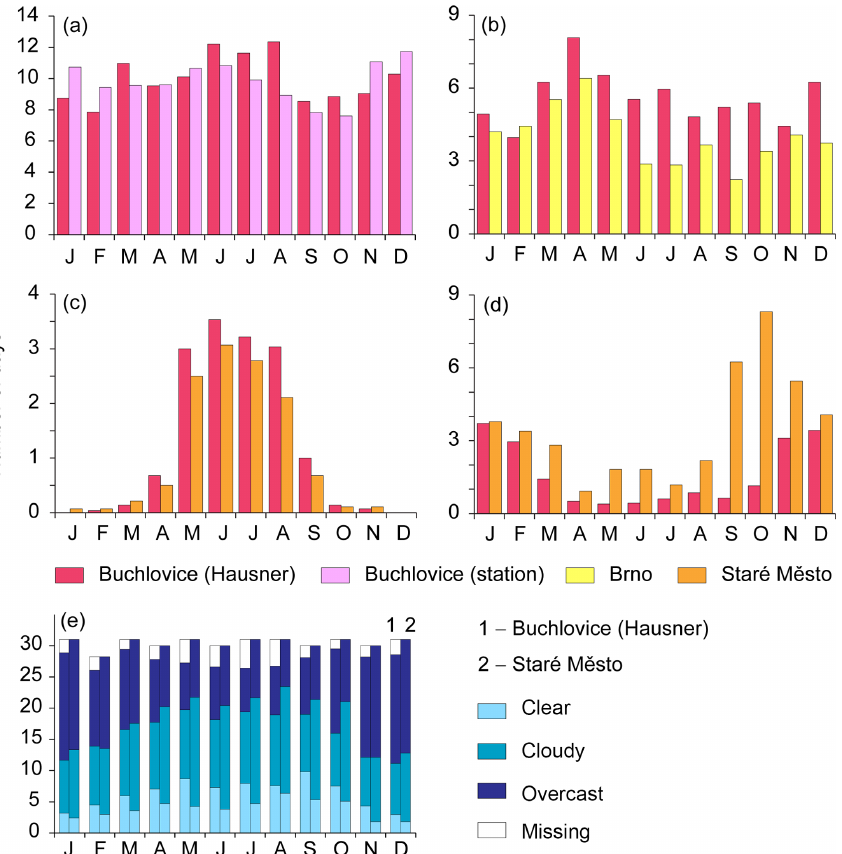
Figure 13. Comparison of annual variation in selected climatological characteristics at Buchlovice interpreted from Hausner’s records for 1803–1830 and at three selected meteorological stations in 1961–1990: (a) number of precipitation days (with totals ≥ 0 . 1mm for the Buchlovice rain-gauge station); (b) number of days with strong winds (with wind force ≥ 7 ◦ B, i.e. wind speed ≥ 10 . 8ms − 1 for Brno); (c) number of days with thunderstorm; (d) number of days with fog; (e) number of days with various degrees of cloudiness: clear days (0–2/10 of cloud cover at Staré Mˇesto), cloudy days (2.1–7.9/10 of cloud cover at Staré Mˇesto, sum of categories 2, 3, and 4 at Buchlovice – see Fig. 7), and overcast days (8–10/10 of cloud cover at Staré